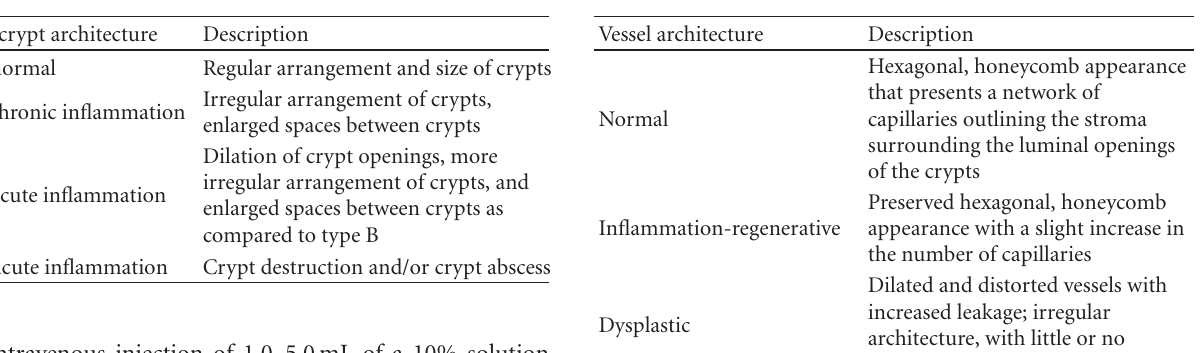
Table 1: Classification of crypt architecture by e-CLE assessment in ulcerative colitis [6].